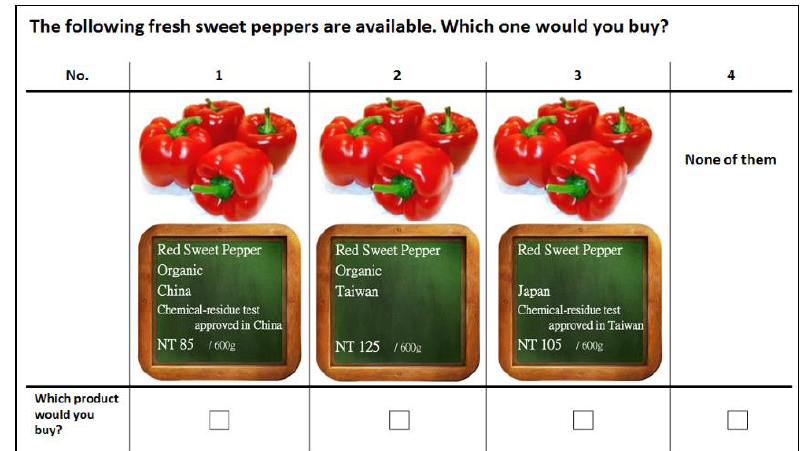
Figure 1. A choice task example in DCE (English translation).